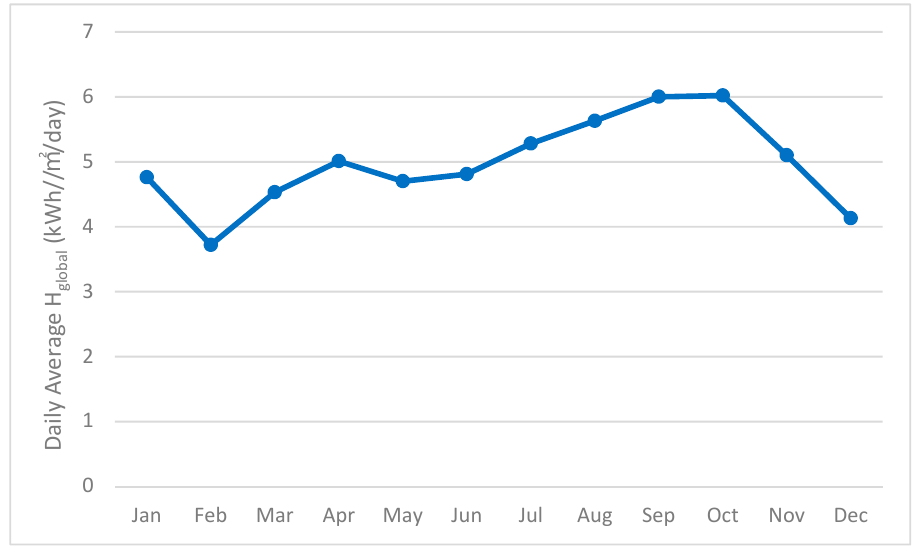
Figure 4. Monthly daily solar irradiation. Data sources: Raghoebarsing, A.; Kalpoe (2017) [10]. Other RE sources used in Suriname are wind energy and biomass energy but these sources are used on small scale.